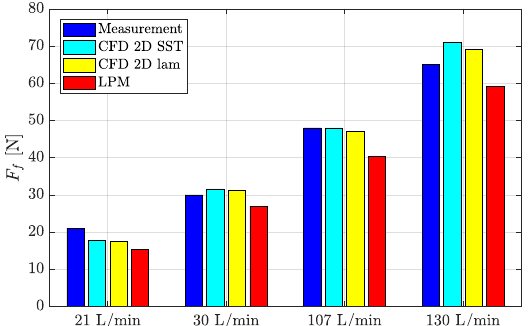
Figure 3: Measurement and simulation comparison of the flow-induced force, F f